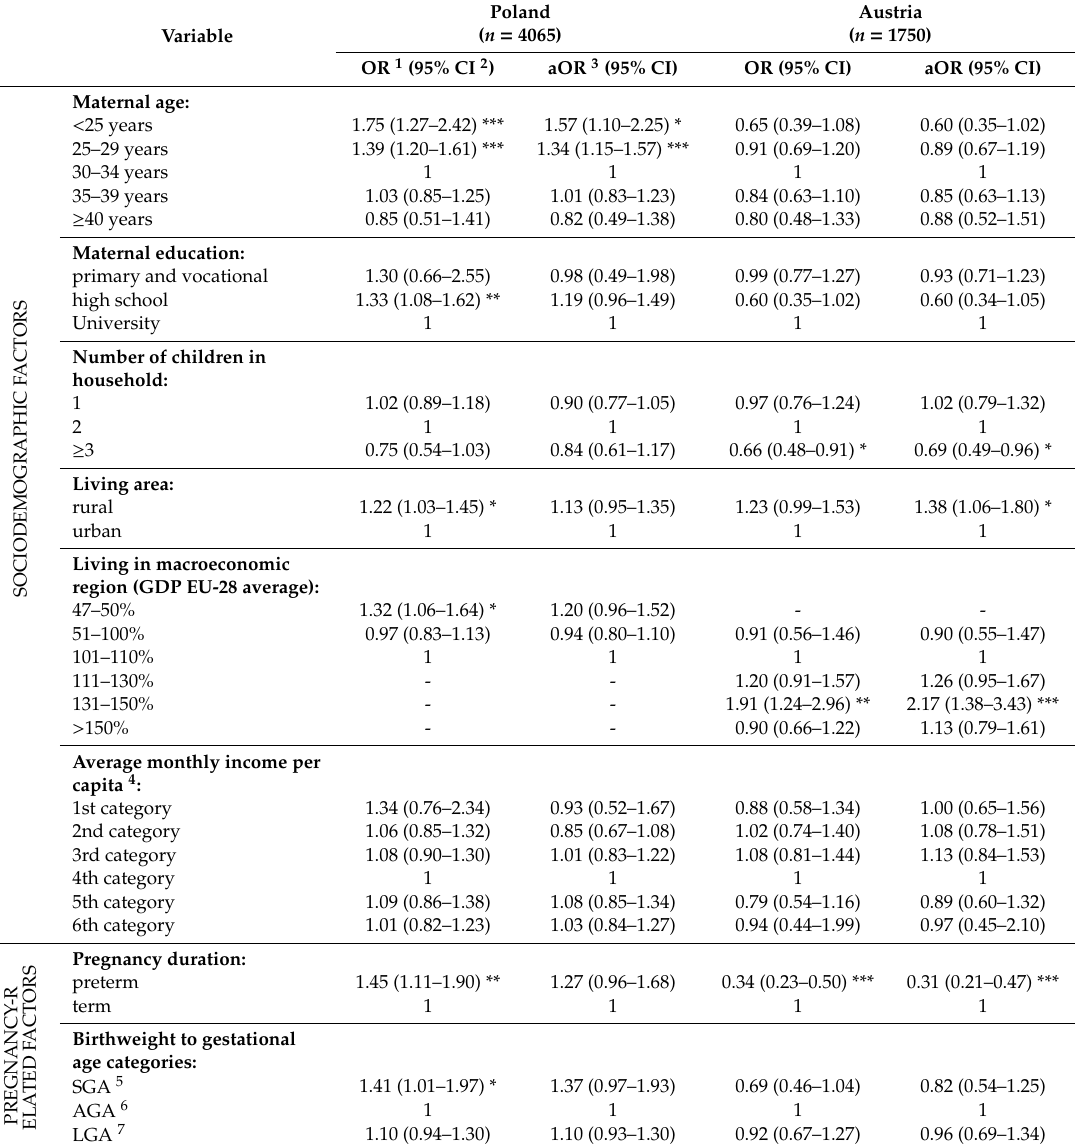
Table 4. Univariateandmultivariateregressionanalysismodelsoffactorsinfluencingthecomplementary feeding introduction at the age of 4–6